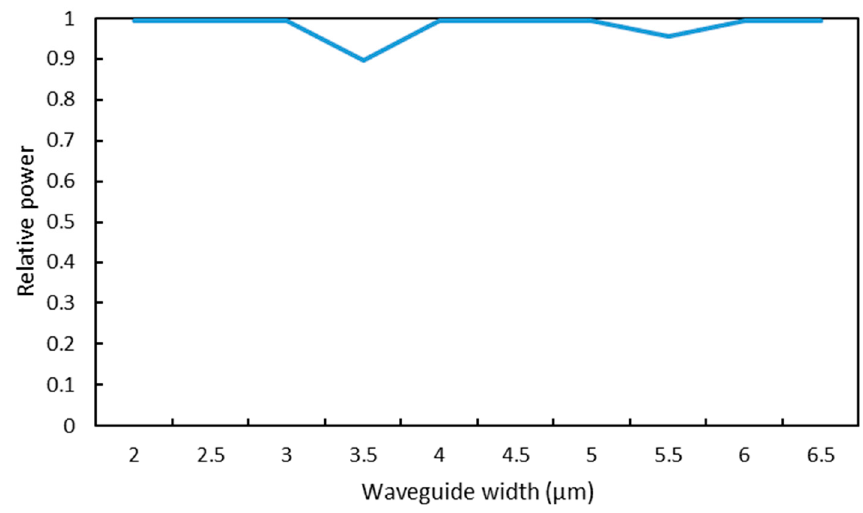
Figure 3. Relative output power for various waveguide widths.